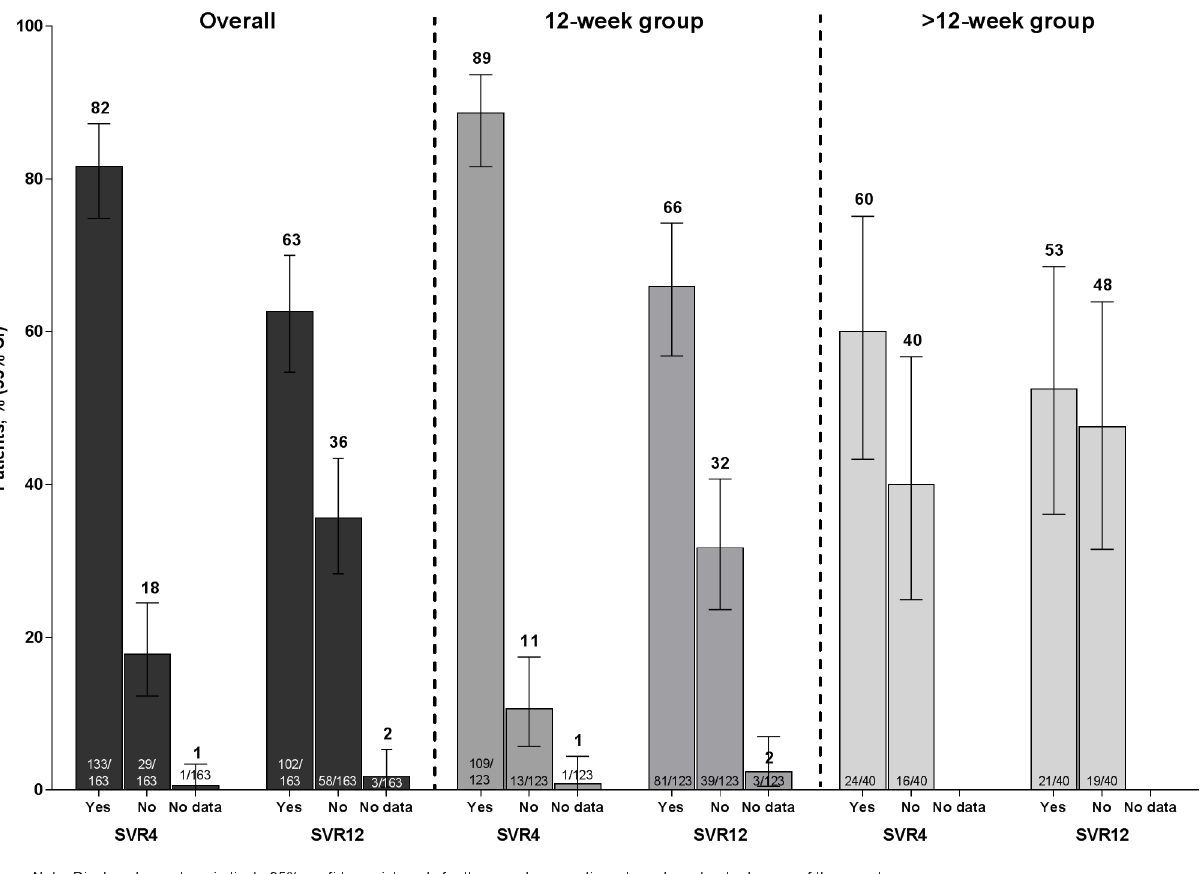
Fig 2. SVR4 and SVR12 rates for all patients, patients receiving 12 weeks of treatment, and patients receiving > 12 weeks of treatment.